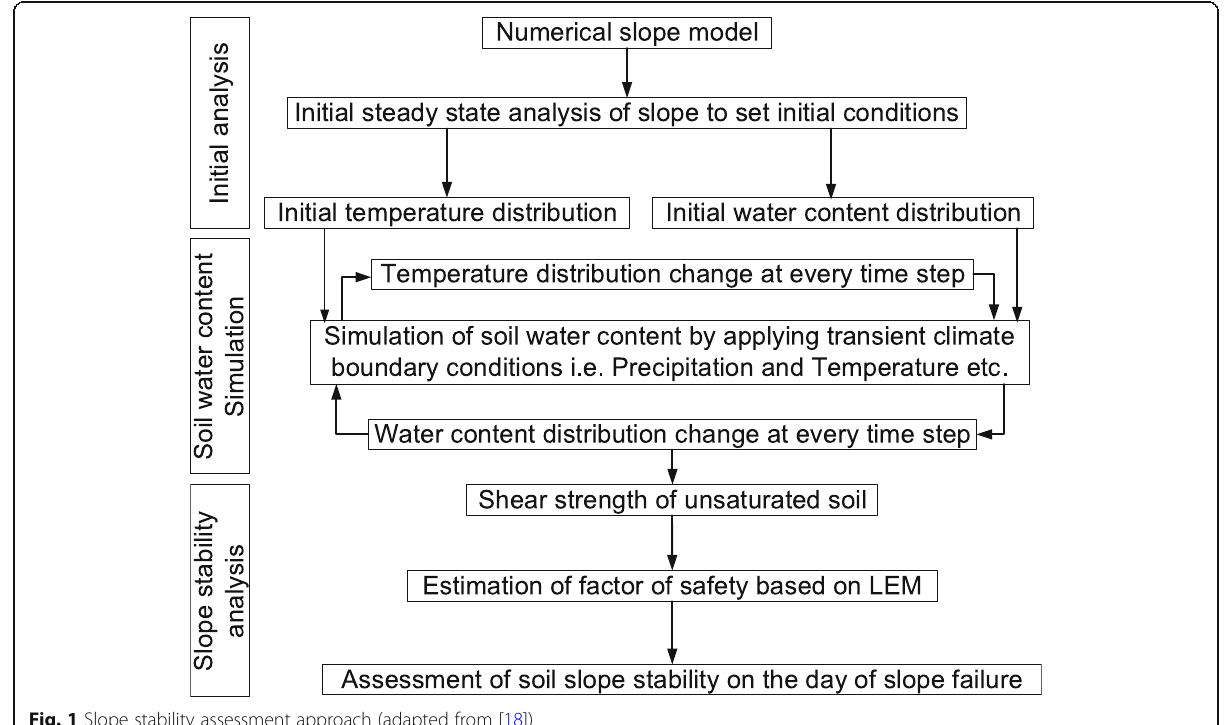
Fig. 1 Slope stability assessment approach (adapted from